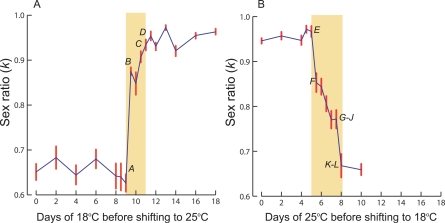
Temperature-Shift ExperimentAt various time points during development from eggs to adults, vials of SSR12-2-7 (nmy) flies were shifted from 18 °C to 25 °C (A) or from 25 °C to 18 °C (B). Seven to 32 males eclosed from each of these vials were tested for sex-ratio, and the results (sex ratio and error bar = SEM) are shown at the time points of temperature shift. The stages of spermatogenesis at critical points (A–L) were examined cytologically (see Figure 7 for the corresponding images).